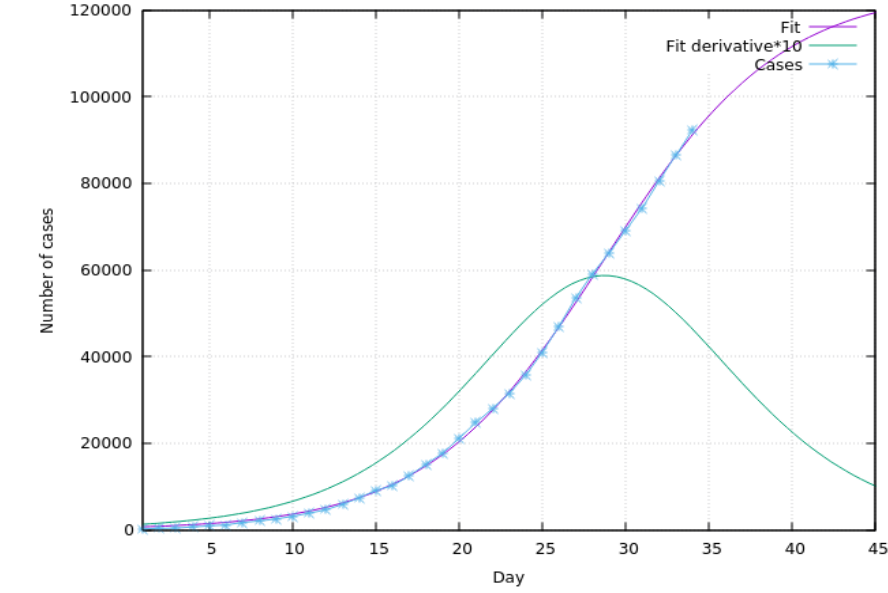
Figure 2 – Extrapolation of the number of cases for the next future Рис . 2 – Экстраполяция числа случаев на ближайшее будущее Слика 2 – Екстраполација броја случајева у блиској